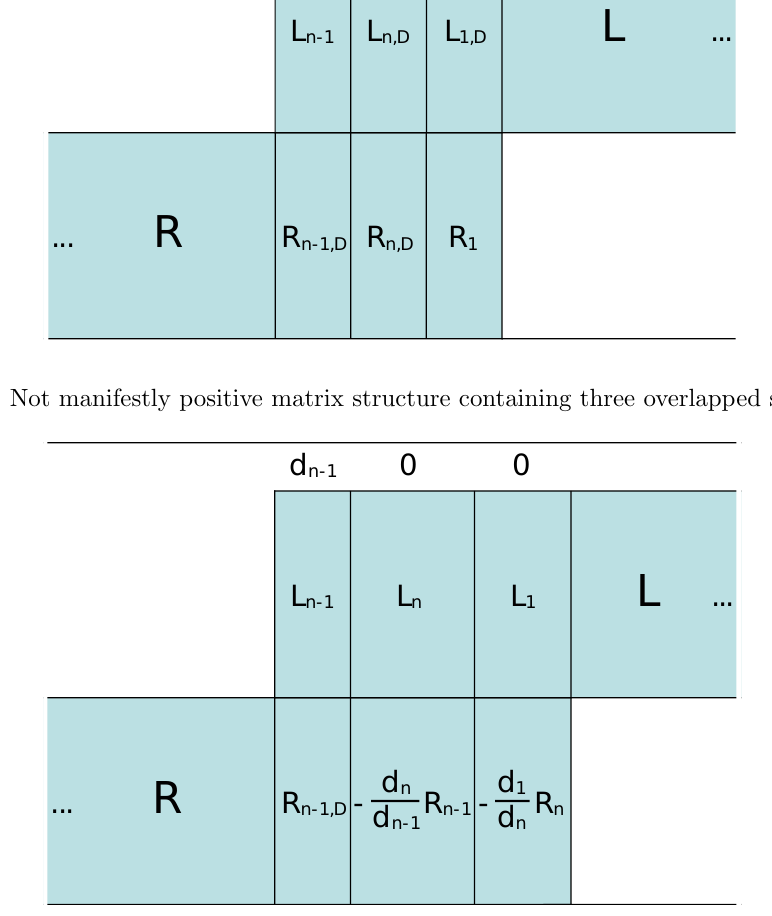
Figure 11 . For any minor containing columns n (cid:0) 1 ; n; 1, d n and d 1 can be removed by shifting columns n;